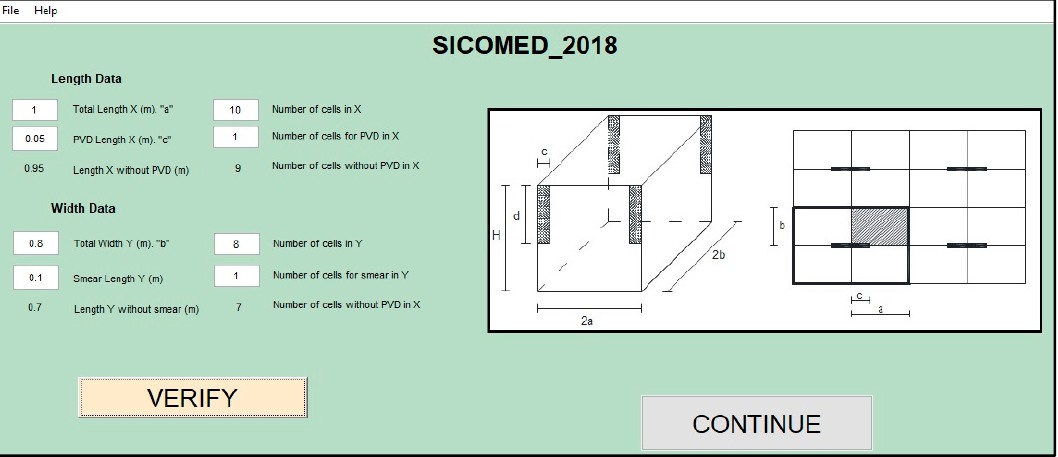
Figure 6. SICOMED_2018 start-up screen.